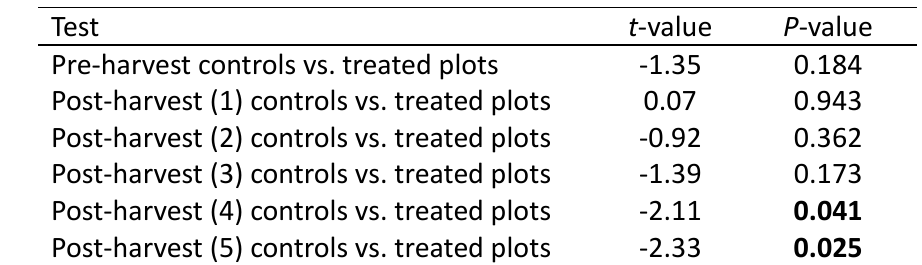
Table A1.7 . Year-specific treatment effects on density of Black-throated Blue Warbler, according to multiple comparison analyses (DF = 40).